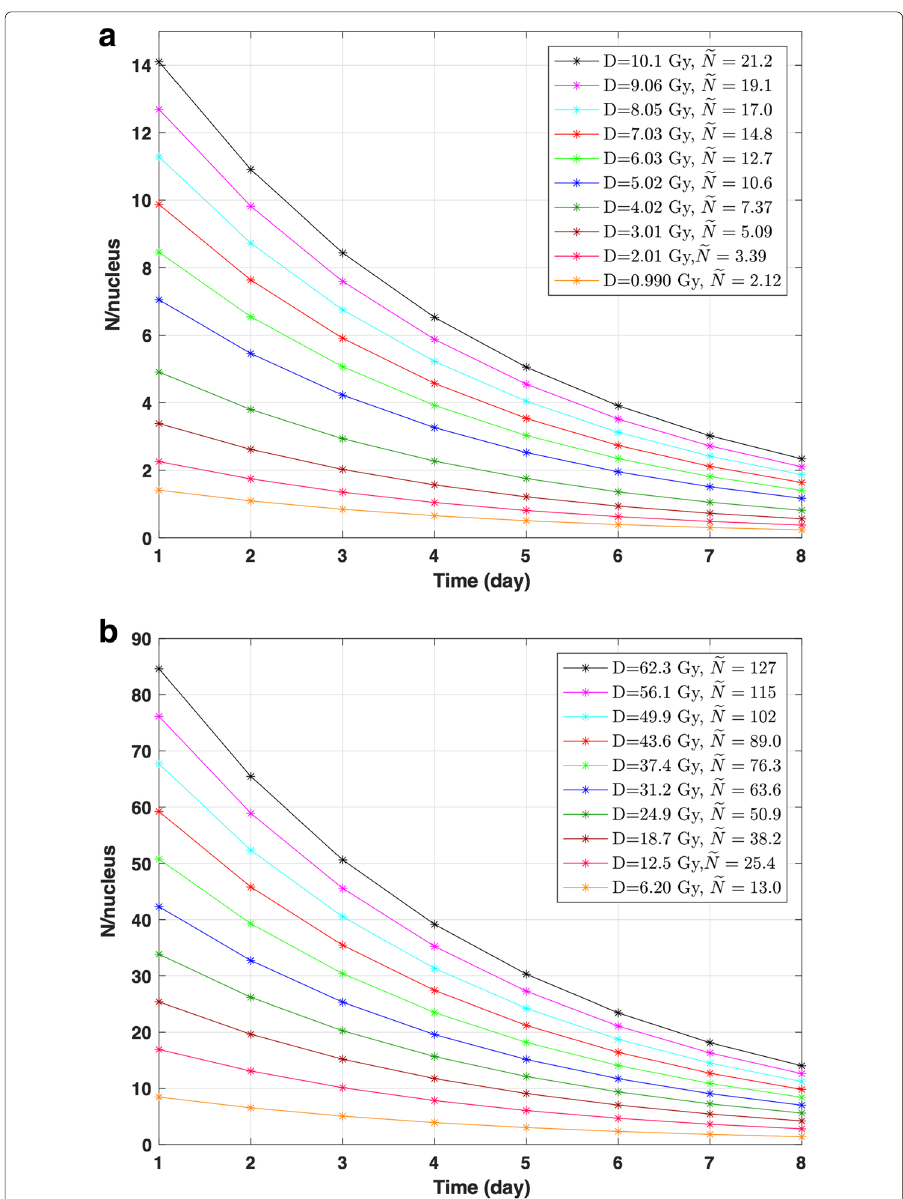
Fig. 7 Histograms of the average number of beta particle hits per cell nucleus N / nucleus binned into each day of irradiation and corresponding average number of hits (cid:5) N for the total 8-day irradiation time calculated from simulations for a LDR– 90 Y and b HDR– 90 Y. D is the total dose ( D